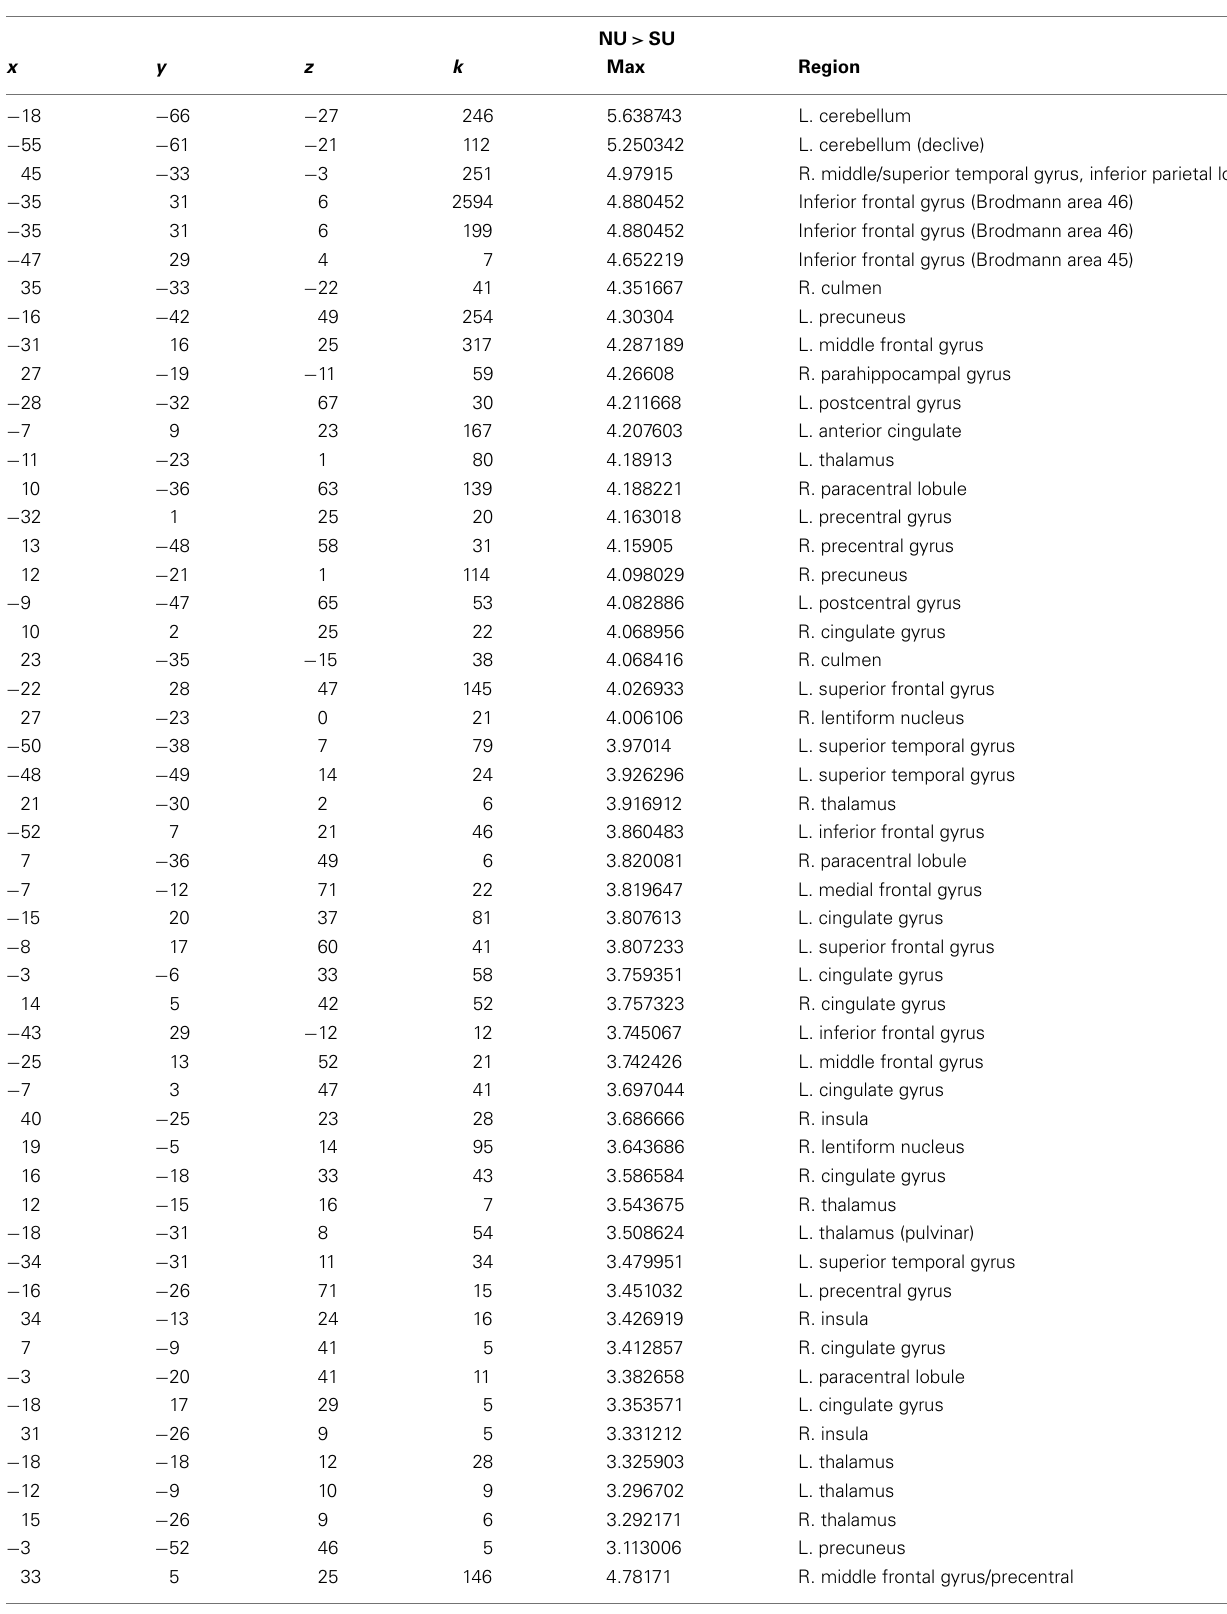
Table 3 | x , y , z coordinates, max activation, and cluster size for the contrast of non-using > substance-using mothers for sad infant